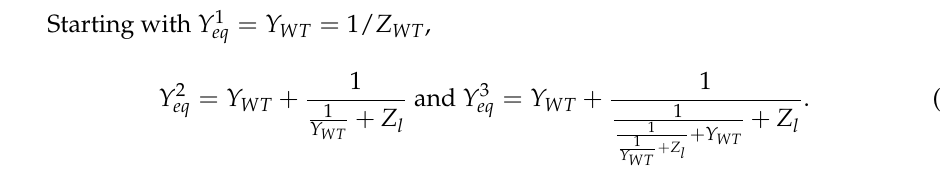
Figure 25. Offshore wind farm grid layout with equivalent circuit diagram for one radial line.